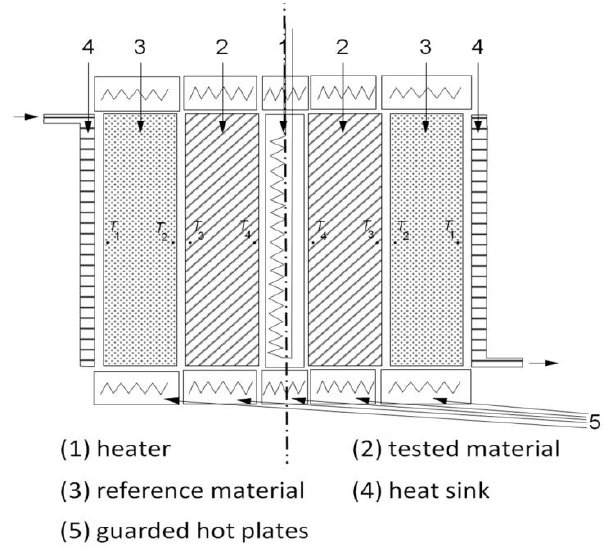
Figure 4. Sketch of the guarded hot plate apparatus.